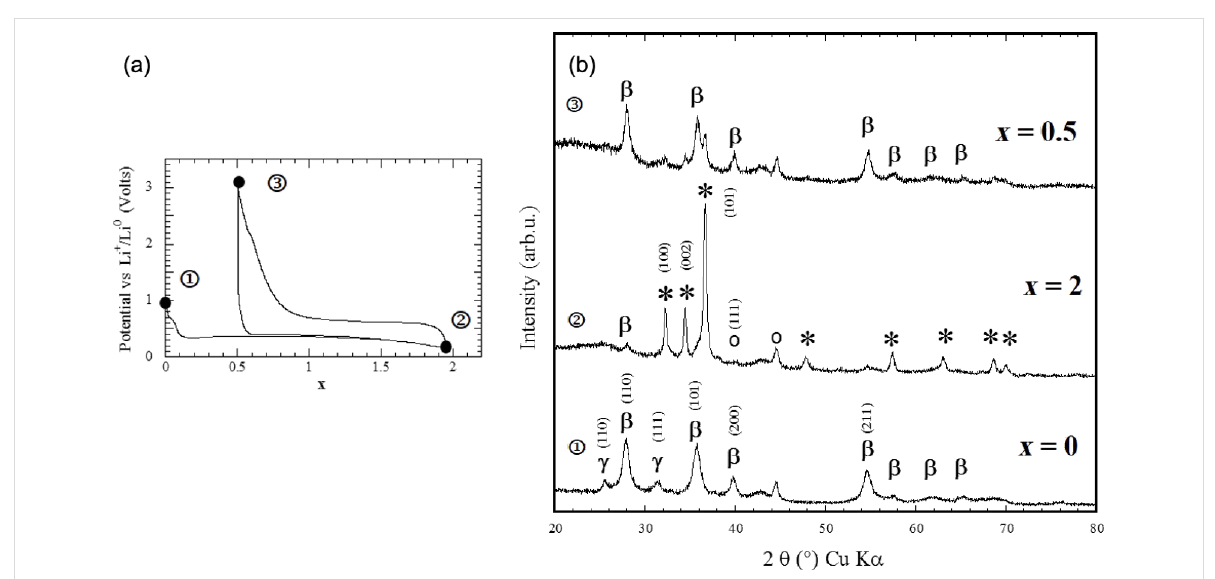
Figure 5: Potential profile and XRD patterns of MgH 2 electrode at various stages of the conversion reaction. a) Evolution of the potential (V) as a function of x for a Li/MgH 2 cell that was cycled down to x = 2 at a rate of one equivalent of lithium in 10 h. b) XRD patterns taken at various stages of the discharge, (1) x = 0 (starting electrode material), (2) x = 2 (end of the first discharge) and (3) x = 0.5 (end of the first charge). The Bragg peaks marked by an asterisk, β , γ , and circle correspond to Mg, β -MgH 2 , γ -MgH 2 and LiH, respectively. Adapted from [5] (copyright 2008 Nature Publishing Group) and